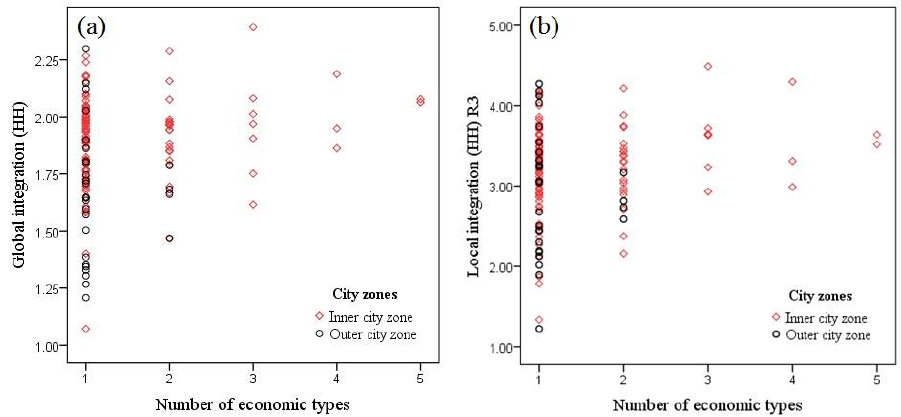
Figure 9. Scatter plots showing relationships between the numbers of economic types for ( a ) the global integration and ( b ) the local integration in the study area. Table 2. Pearson correlation coefficients between the points of interest characteristics and integra- tion values .